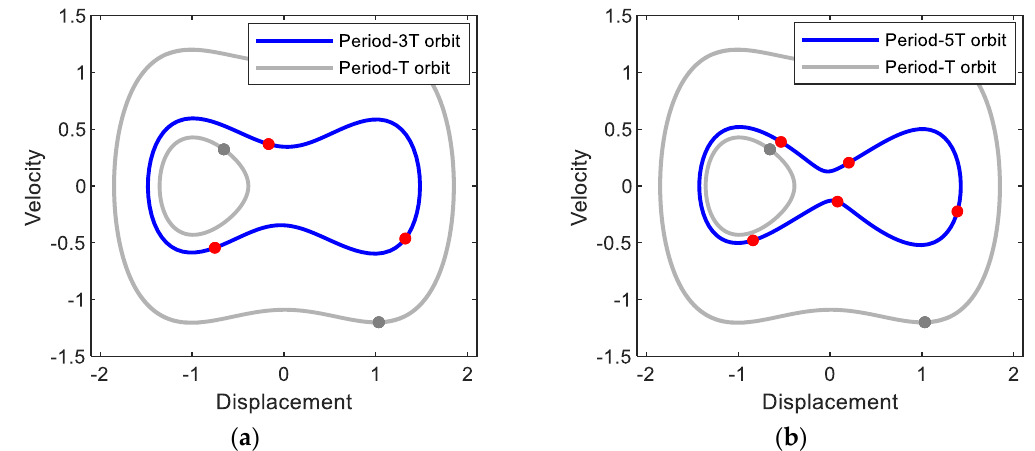
Figure 4. Phase plane representations of ( a ) period-3 T and ( b ) period-5 T motions obtained with the base acceleration of A = 0.02 and forcing frequencies of ( a ) ω = 1.37 and ( b ) ω = 1.65, respectively. The period- T interwell and intrawell motions of Figure 2b are also presented for comparison purpose. The solid circle dots indicate the stroboscopic projections of the oscillations, which are synchronized with the period T of the base excitation.